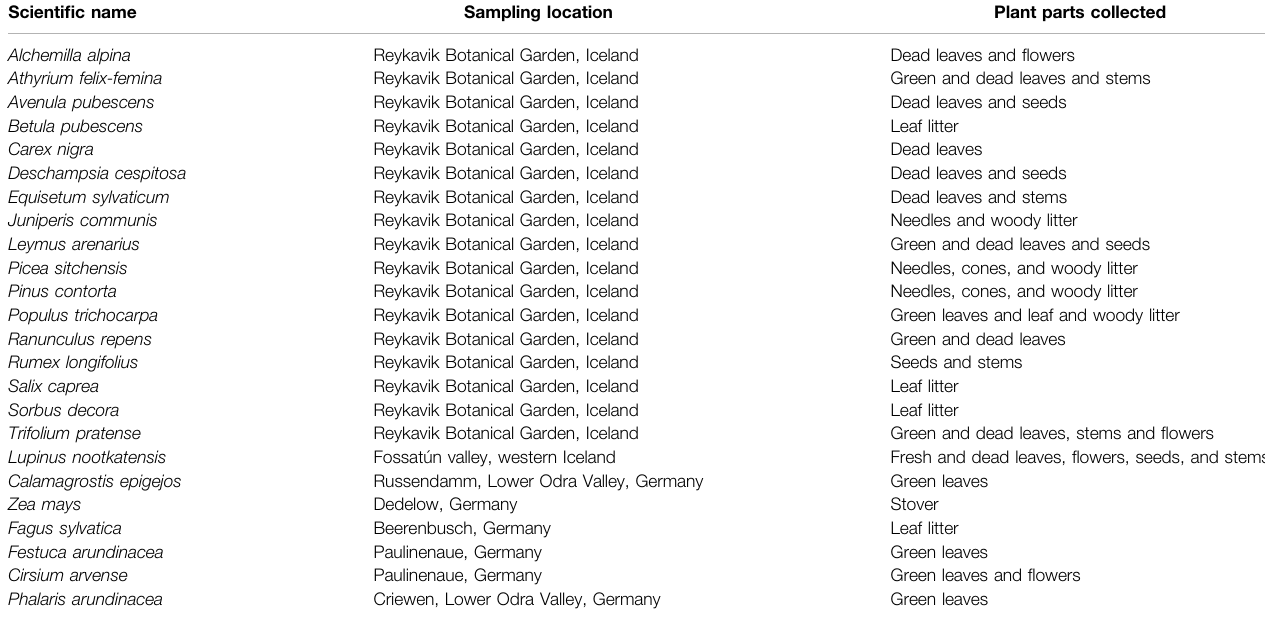
TABLE 1 | List of plant species and sampling